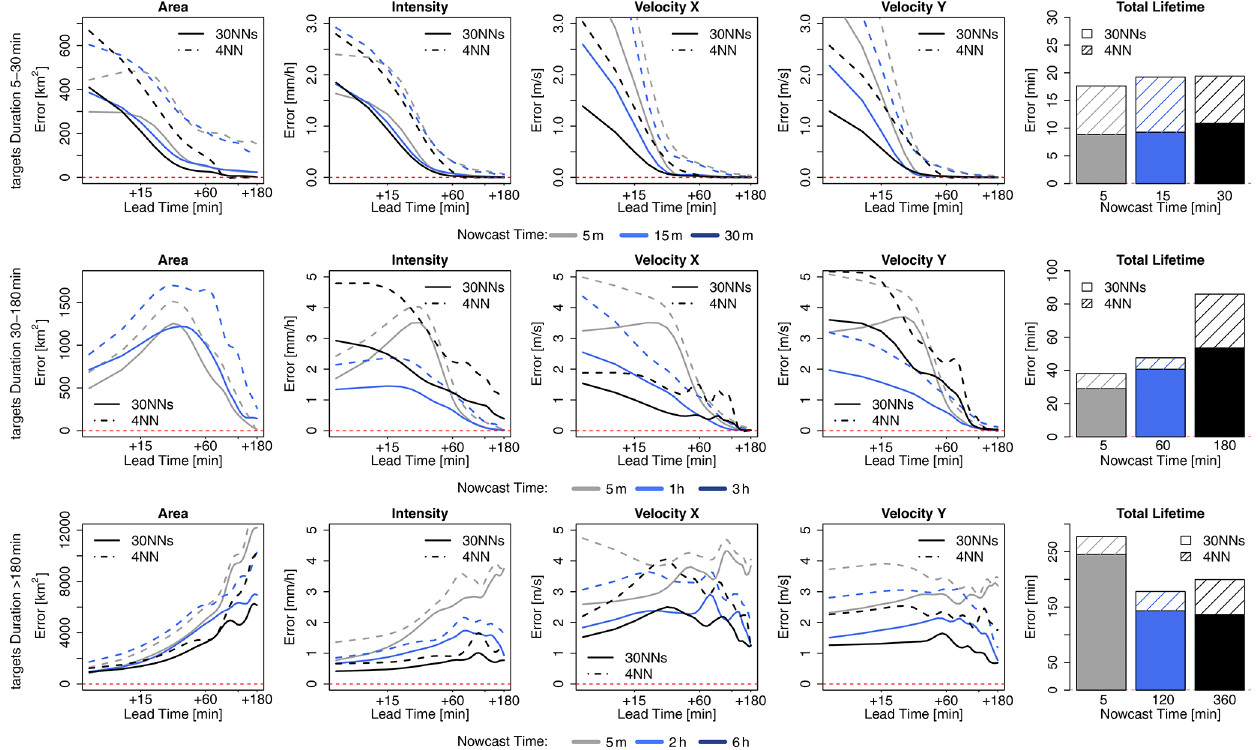
Figure 12. The median CRPS over all the events for each target variable (area, intensity, and velocity in the x and y directions and total lifetime) in the target-based applications: 4-NN (deterministic) in dashed and 30NNs (probabilistic) in solid lines. The median errors are computed over storms that are shorter than 30min (upper row), shorter than 3h (middle row), and longer than 3h (lower row) and over the selected nowcast